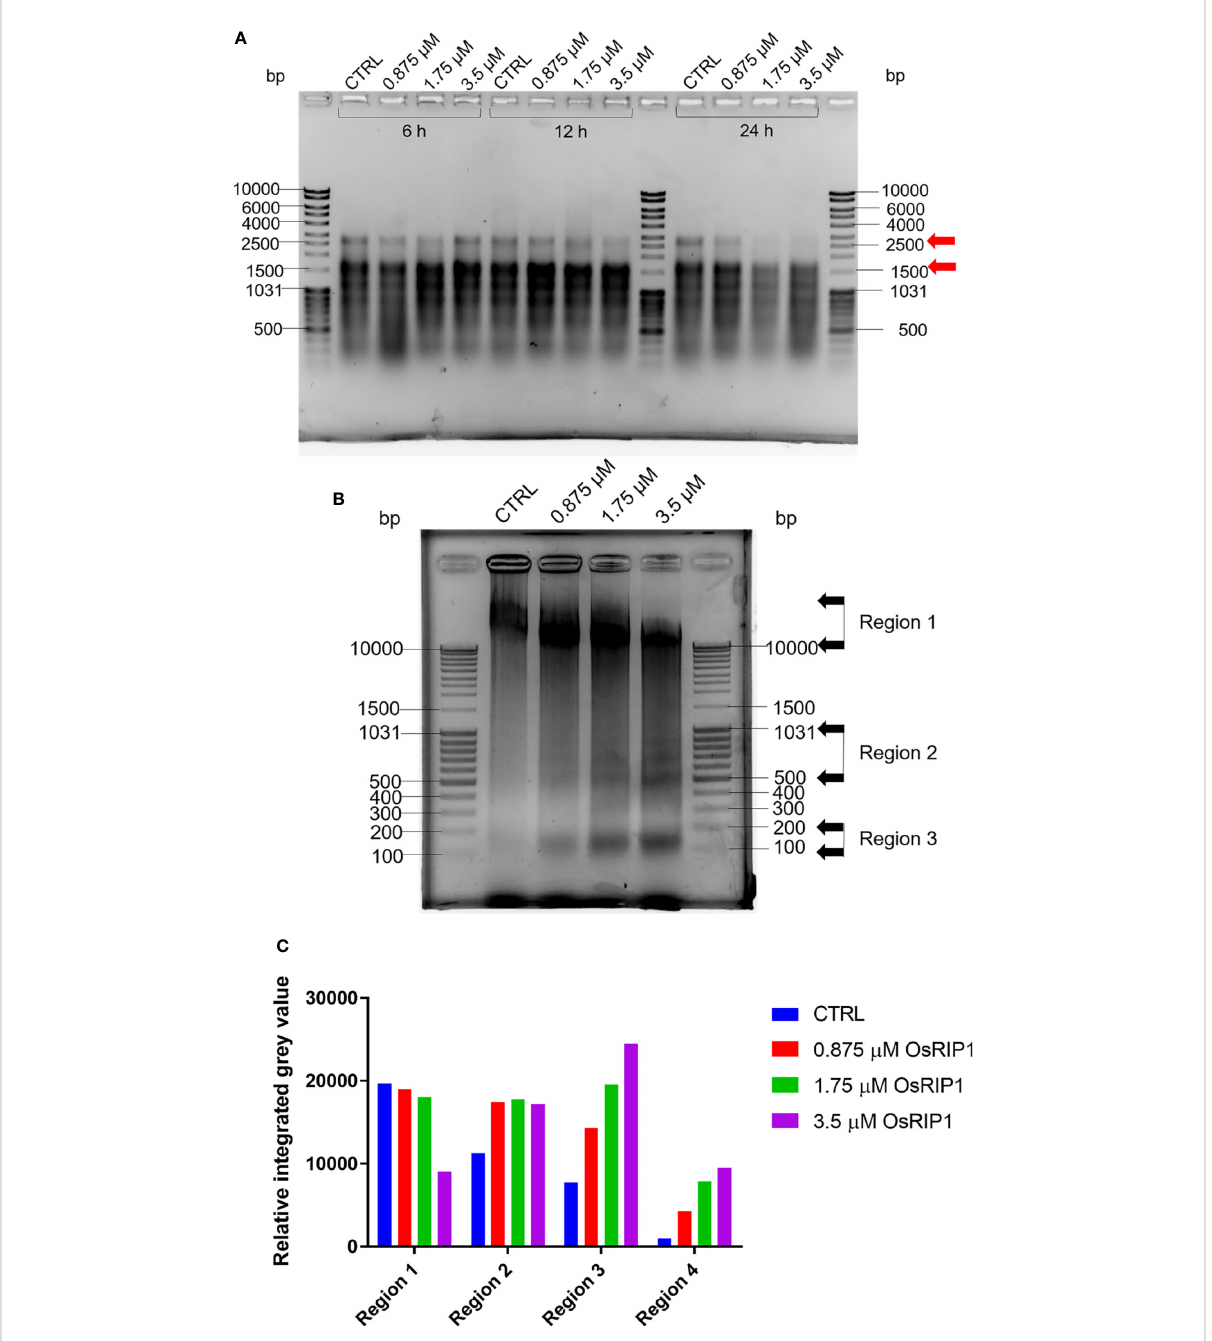
FIGURE 5 Agarose gel electrophoresis for nucleic acid samples of cultured tobacco BY-2 cells treated with OsRIP1 at 0 (CTRL), 0.875, 1.75, 3.5 m M. (A) 1 m g of total RNA. (B) Genomic DNA (11.693 m g) extracted from tobacco BY-2 cells (representative samples from three independent experiments) at 48 h after control (CTRL) or OsRIP1 treatment. MassRuler DNA Ladder Mix (5 m l, Thermo Scienti fi c) were loaded in the gels. (C) Quantitative analysis of regions indicated with grey arrows in (B) using the software ImageJ in grayscale